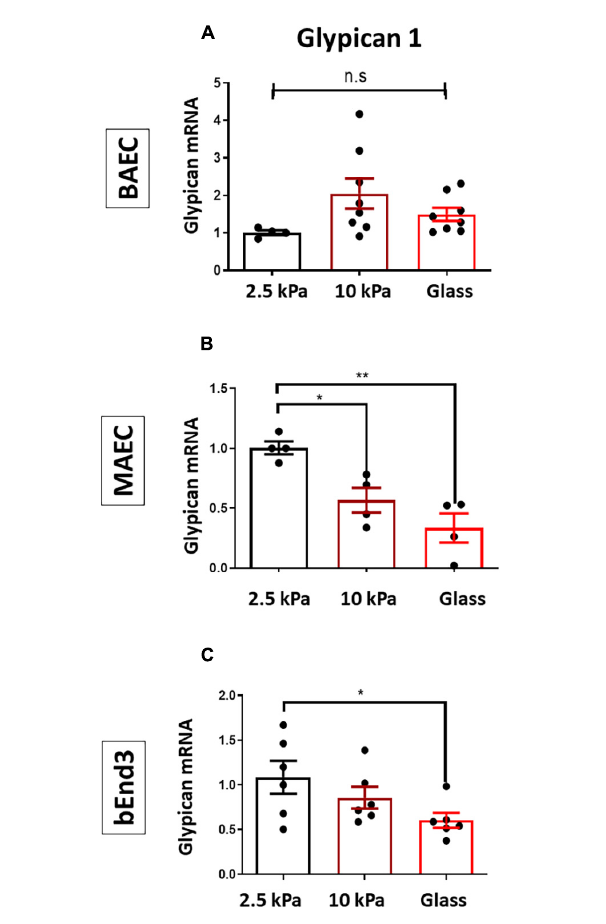
FIGURE 3 | Stiffness inhibits the expression of Glypican 1 in endothelial cells. (A) BAECs, (B) MAECs, and (C) bEnd3 were cultured onto polyacrylamide gels at stiffness of 2.5 kPa (soft gel), 10 kPa (stiff gel) or on glass until confluent. The expression of Glypican 1 mRNA was assessed by qPCR from cells cultured on either 2.5,10 kPa gels or on glass. Hypoxanthine phosphor-ribosyl transferase (HPRT) was used as a housekeeping gene. Mean values ± SEM are shown. N = 5–8, * P < 0.05 and ** P < 0.01 using a One-way ANOVA test. N.S indicates no statistically significant difference was found.